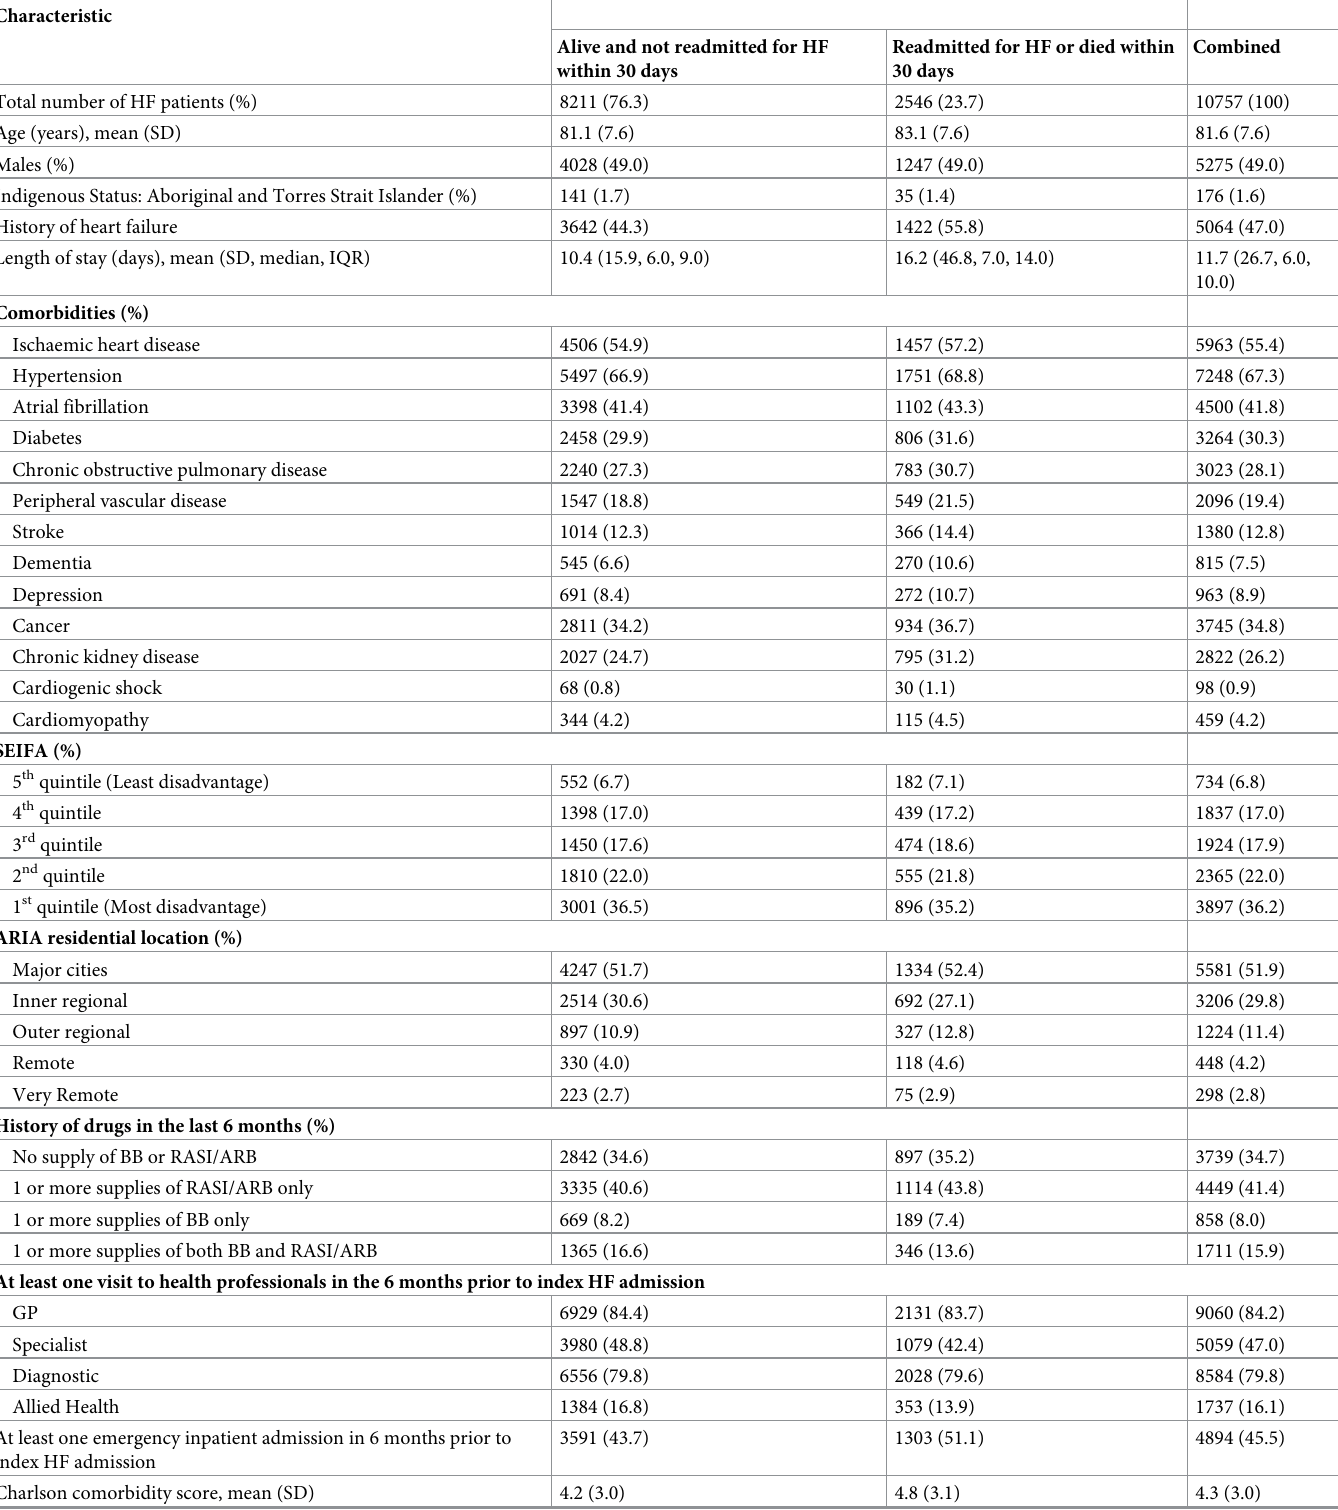
Table 1. Characteristics of heart failure patients in the study cohort (n =